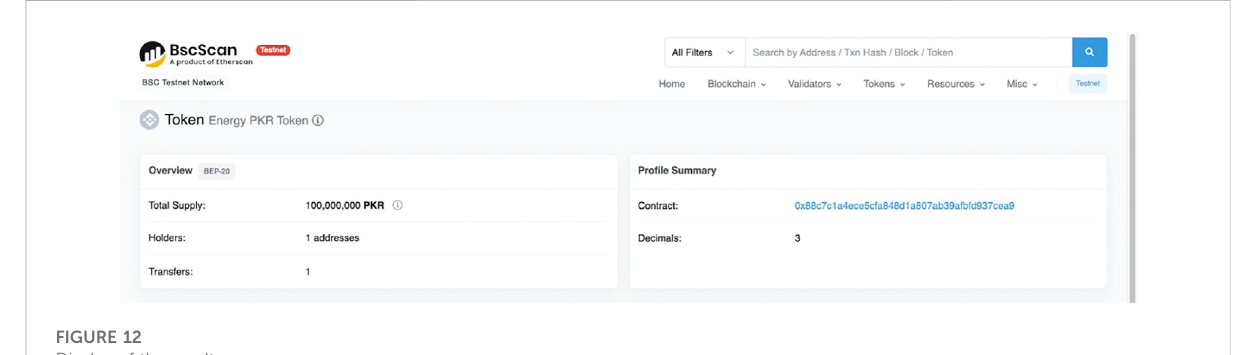
FIGURE 12 Display of the